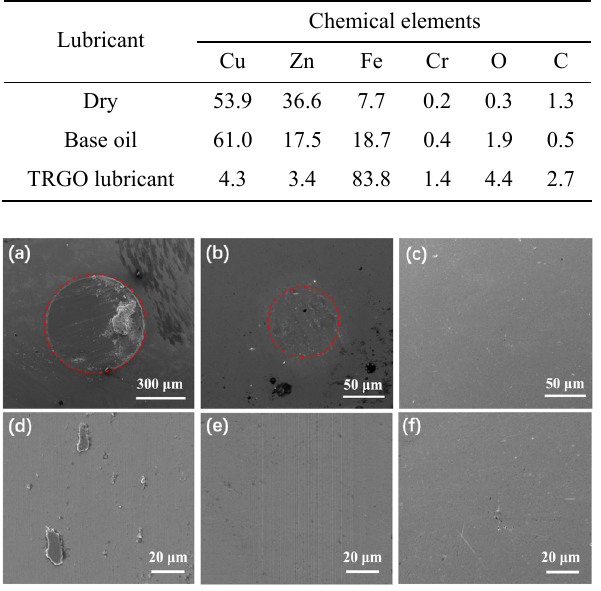
Fig. 9 SEM images of wear scars for (a)–(c) steel balls against (d)–(f) steel disks after friction tests in 3 N. Panels (a) and (d) for dry friction, (b) and (e) are with the base oil, and (c) and (f) are with the TRGO lubricant.